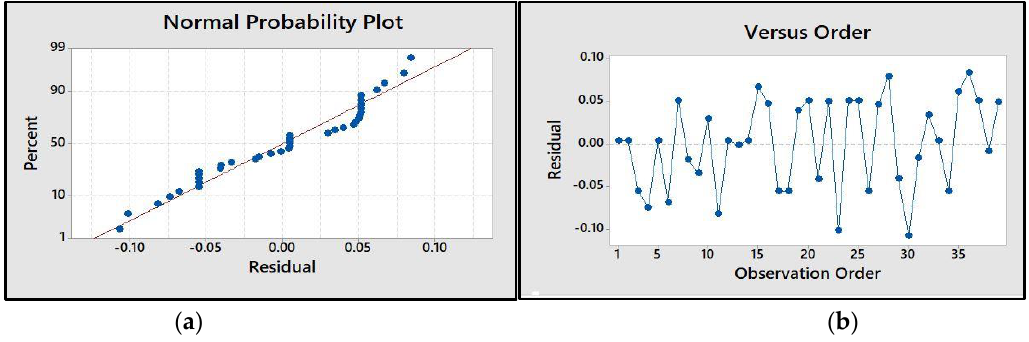
Figure 4. ( a ) Normal probability plot for standardized residuals of Si, and ( b ) versus fits for standardized residuals of Si.